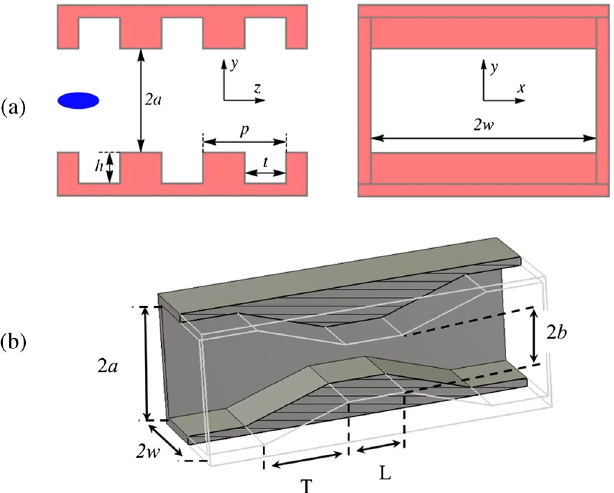
FIG. 1. Structures of constant width: (a) dechirper, (b) tapered